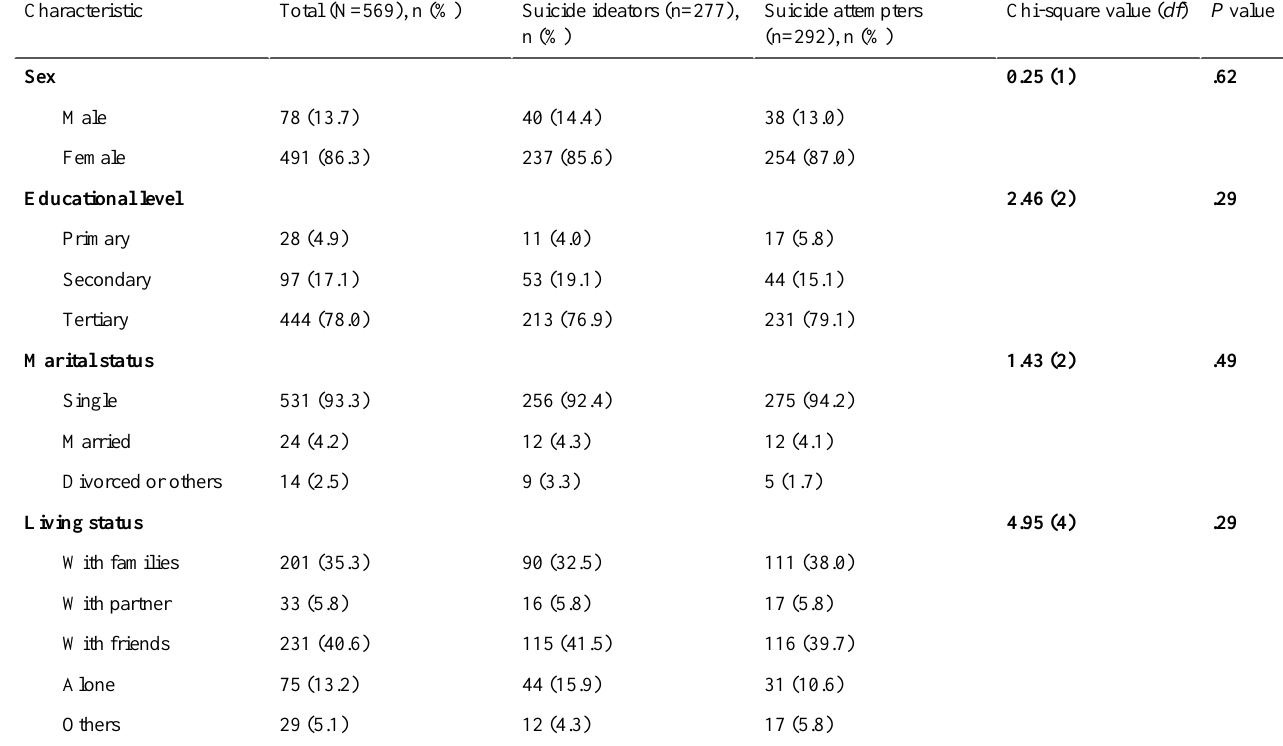
Table 1. Demographic characteristics of participants by suicidal status